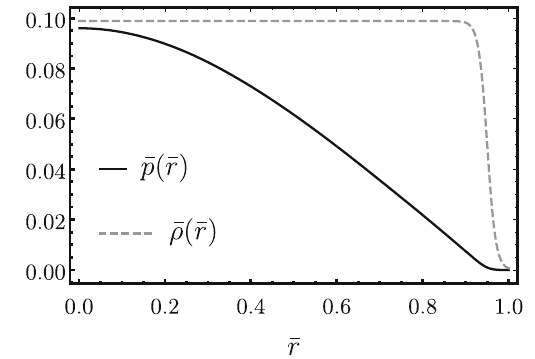
Fig. 1 The plot shows an example of the radial dependence of the density and the pressure of the models considered here